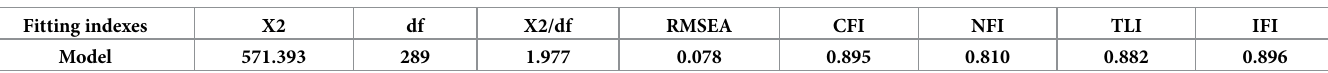
Table 3. The fitting index of CFA of old residential